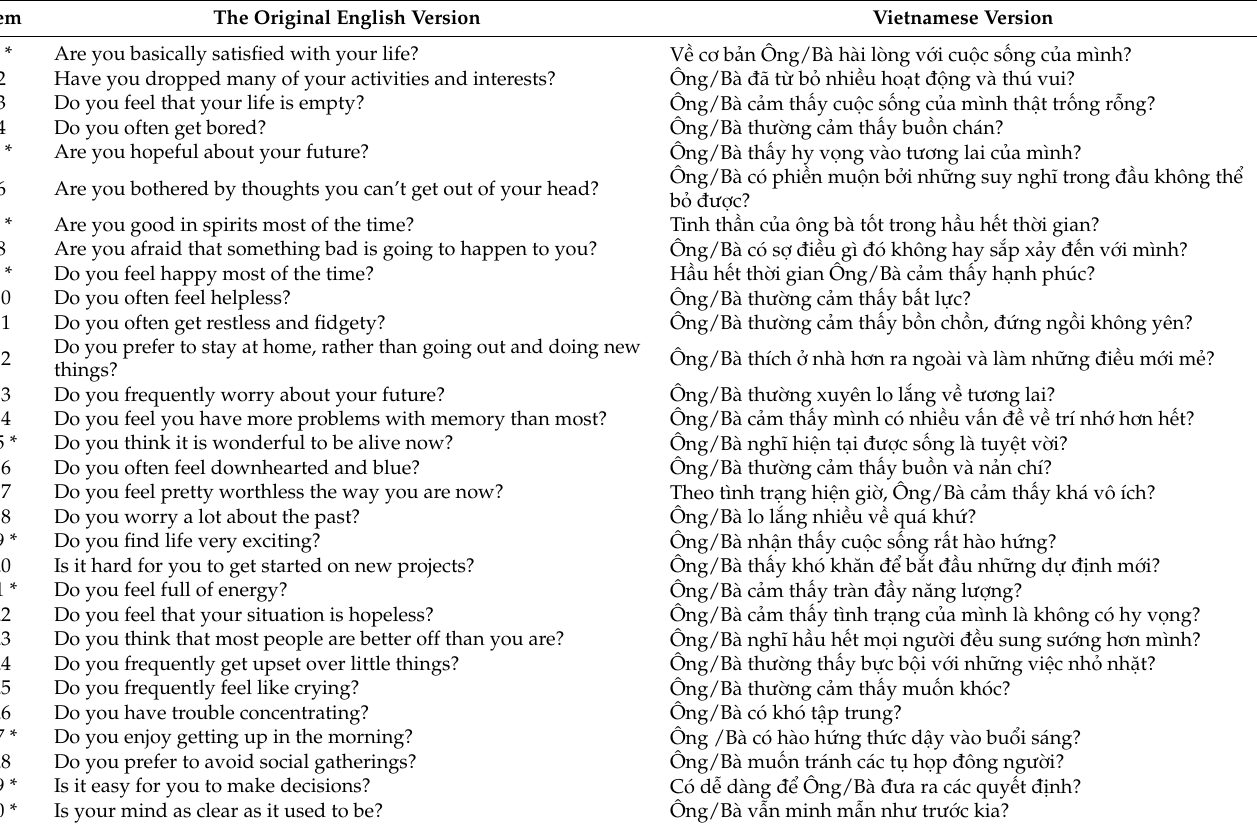
Table 1. The original English version and the Vietnamese version of the GDS.